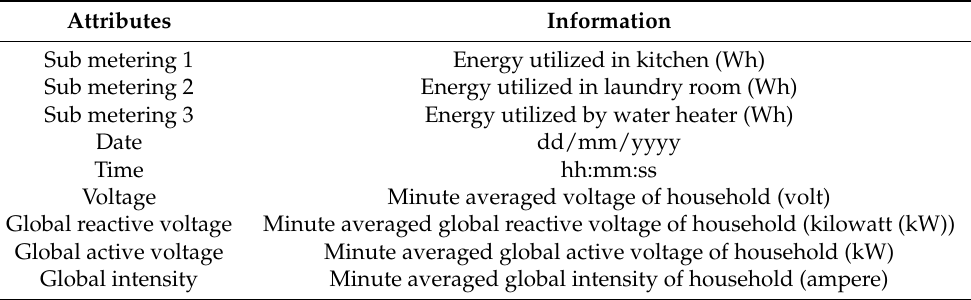
Table 2. Statistical information about IHEPC